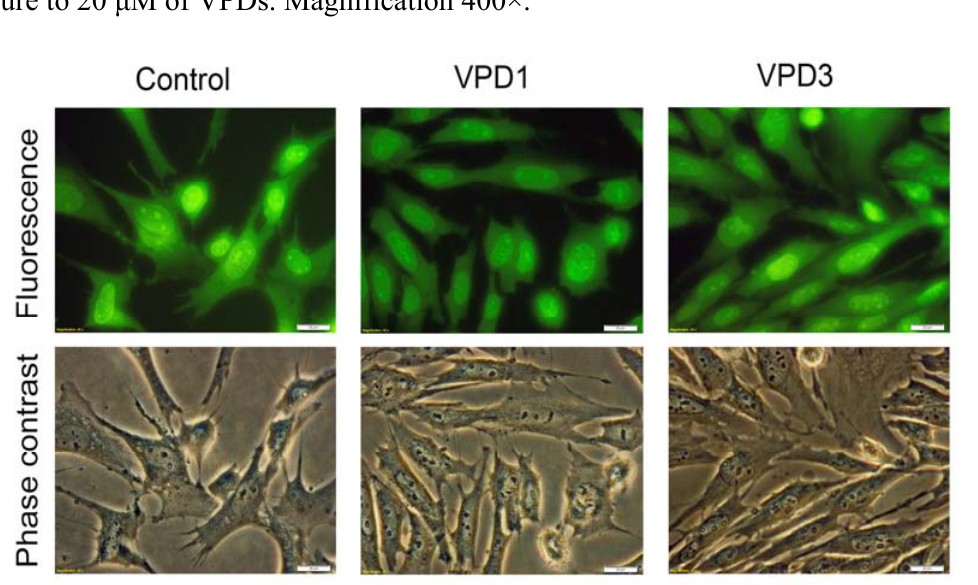
Figure 7. Fluorescence/phase contrast microscopy analyses of mHippoE-18 cells after 24 h exposure to 20 μ M of VPDs. Magnification